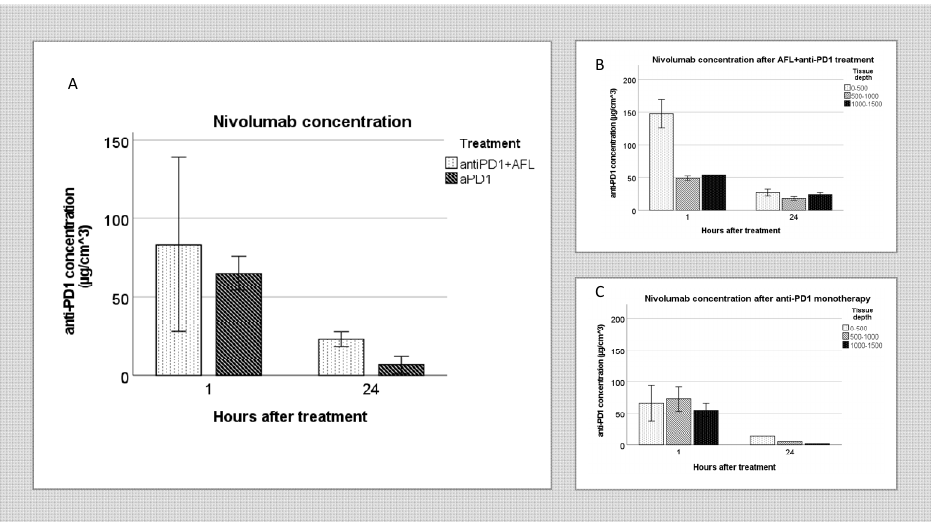
Figure 4. Tumoral anti ‐ PD1 concentration. ( A ) illustrates the drug concentration in the entire skin biopsy (all three skin depths combined) after anti ‐ PD1 + AFL ( n = 2, 1 h, n = 2, 24 h) and anti ‐ PD1 monotherapy ( n = 1, 1 h, n = 3, 24 h) 1 h and 24 h following intervention. ( B , C ) show drug concentration in three different skin depths of the biopsy following anti ‐ PD1 and adjuvant AFL ( B ) and anti ‐ PD1 monotherapy ( C ).